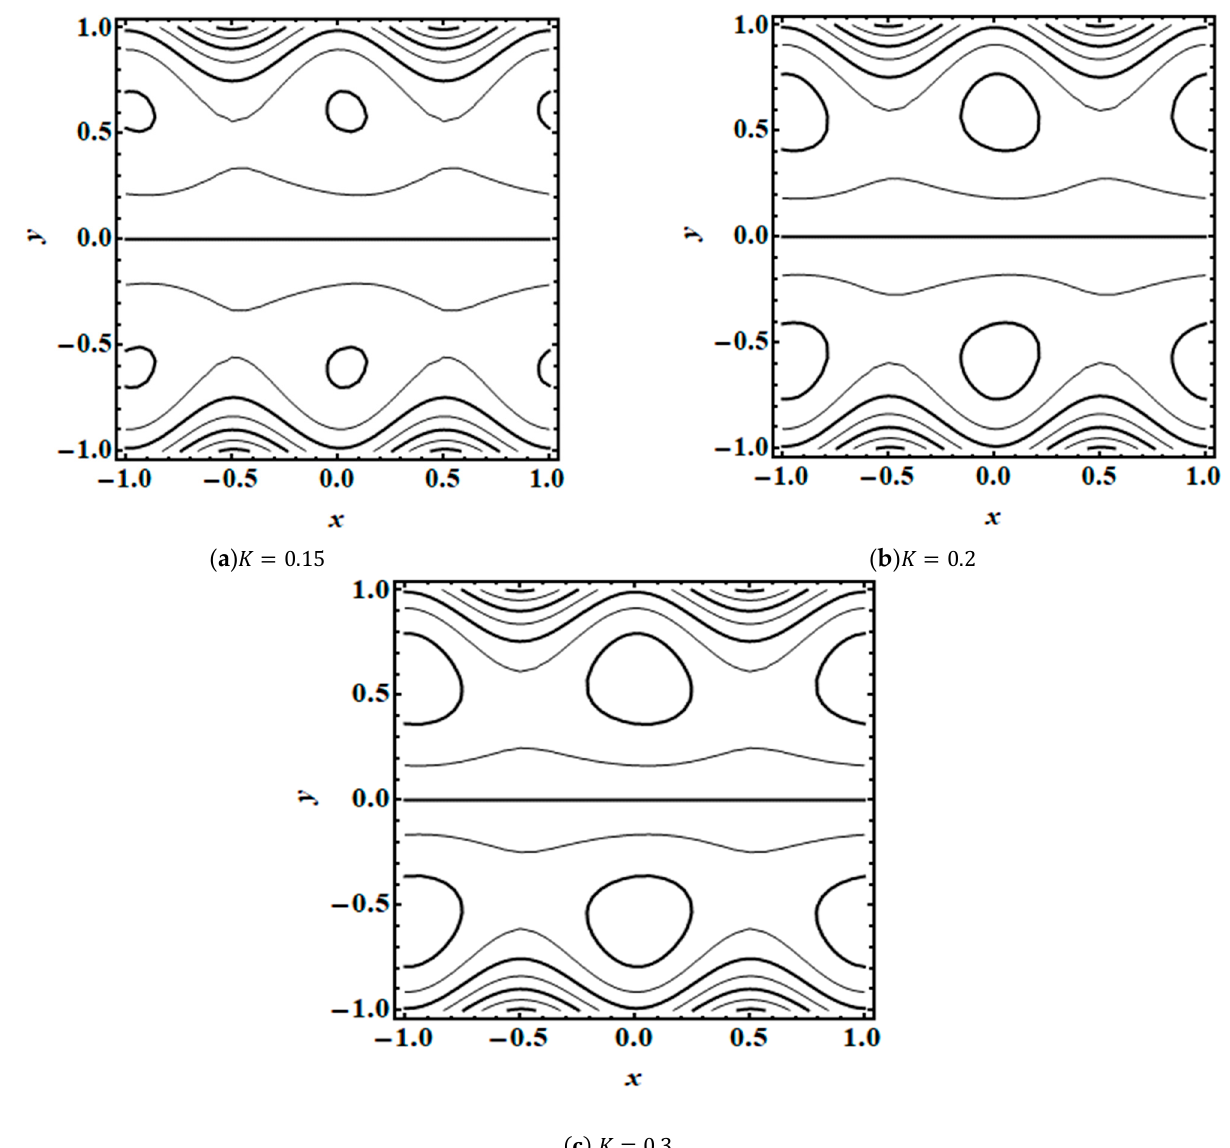
Figure 7. Influence of the porosity parameter 𝐾 on the streamline patterns for 𝛼 = 0.4, 𝛽 = 0.4, 𝜀 = 0.1,𝑄